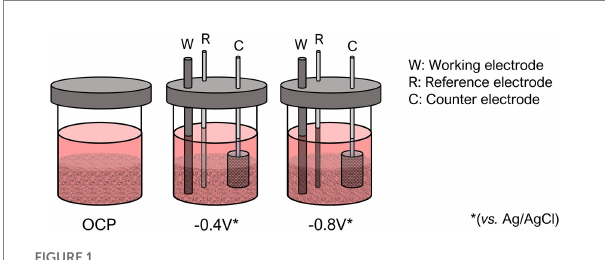
FIGURE 1 Scheme of the experimental set-up used for the photo- electrofermentation screening with brewery